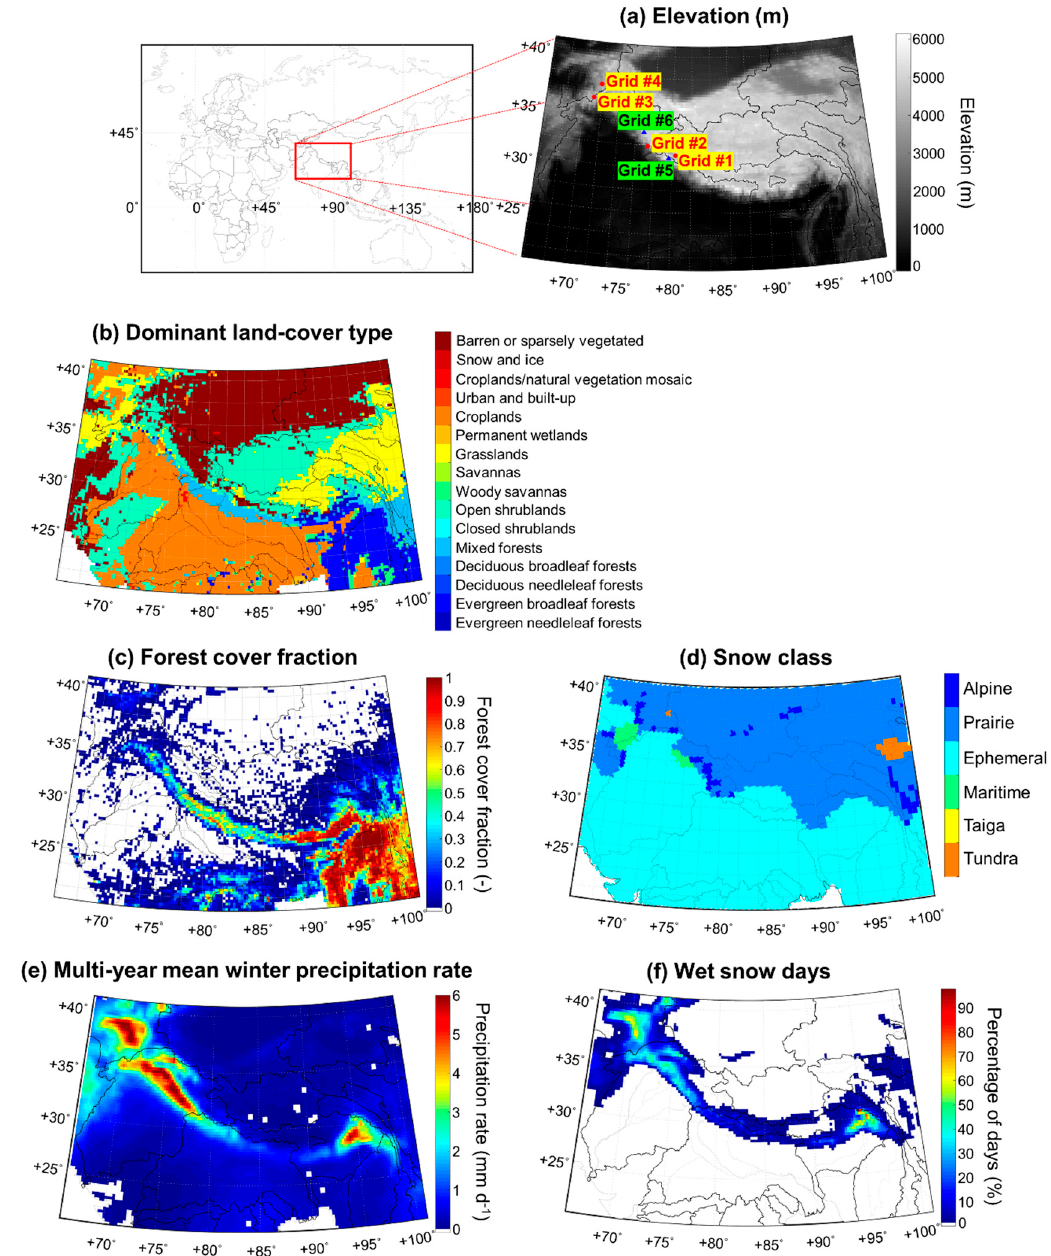
Figure 2. High Mountain Asia (HMA) study domain with experimental grid points (i.e., Grids #1 to #4): ( a ) elevation, ( b ) dominant land-cover types, ( c ) forest cover fraction, ( d ) snow class, ( e ) multiyear mean winter (December, January, and February) precipitation rate, and ( f ) wet snow days. Grids #5 and #6 are glaciated regions presented in Figure 4e,f respectively. Digital elevation estimates derived